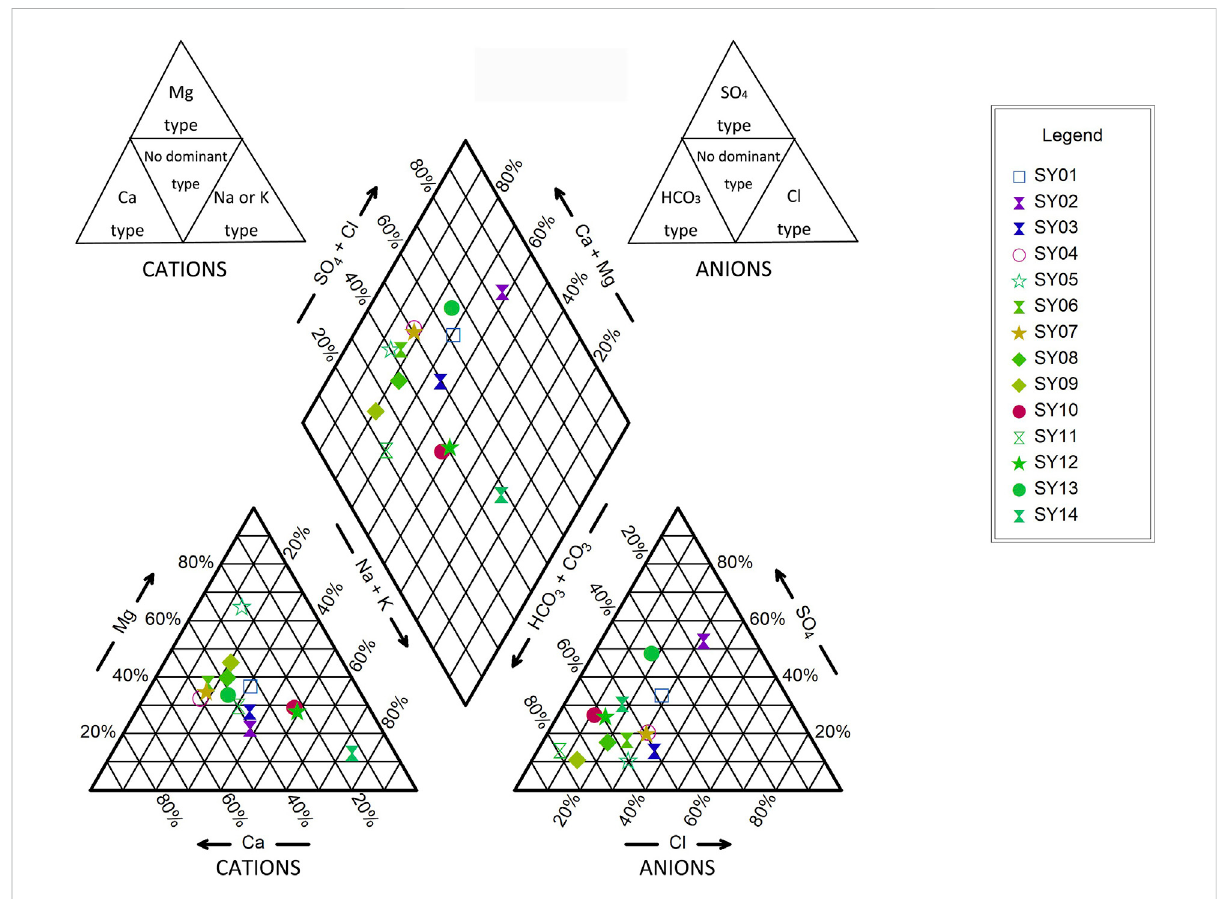
FIGURE 9 Piper diagrams of groundwater sampled from the Yongding River alluvial fan.